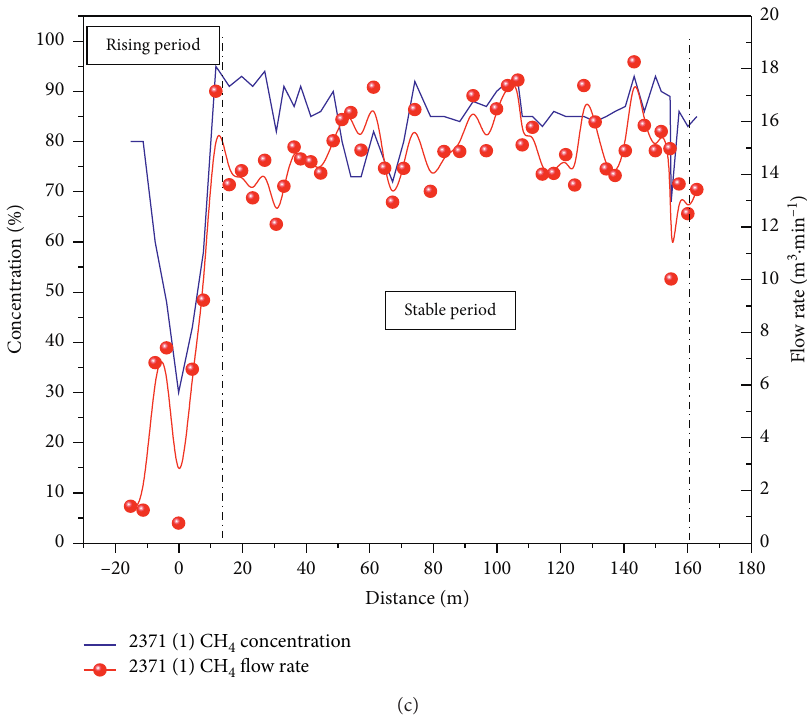
Figure 3: Diagram illustrating gas concentration and flow rate in gas extraction and pressure relief for typical single surface wells: (a) protective layer working face 2662(1), (b) protective layer working face 2371(1), and (c) protective layer working face 2371(1) rising